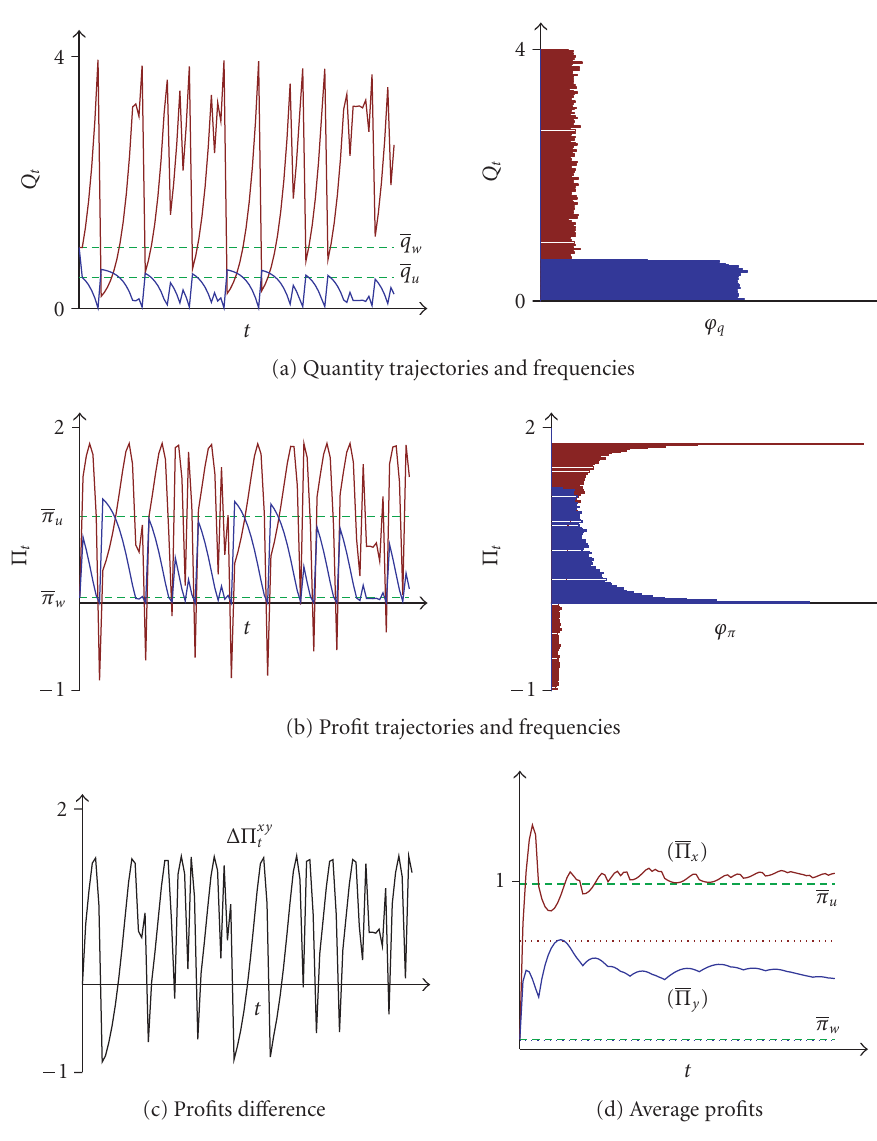
Figure 6.1. Chaotic fluctuations, m = 3, σ = 1 / 8, β = β max